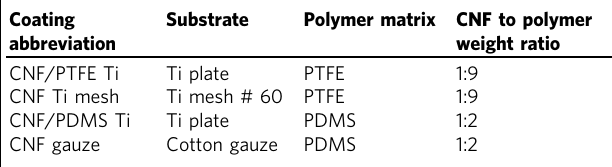
Table 1 Superhydrophobic nanocomposite